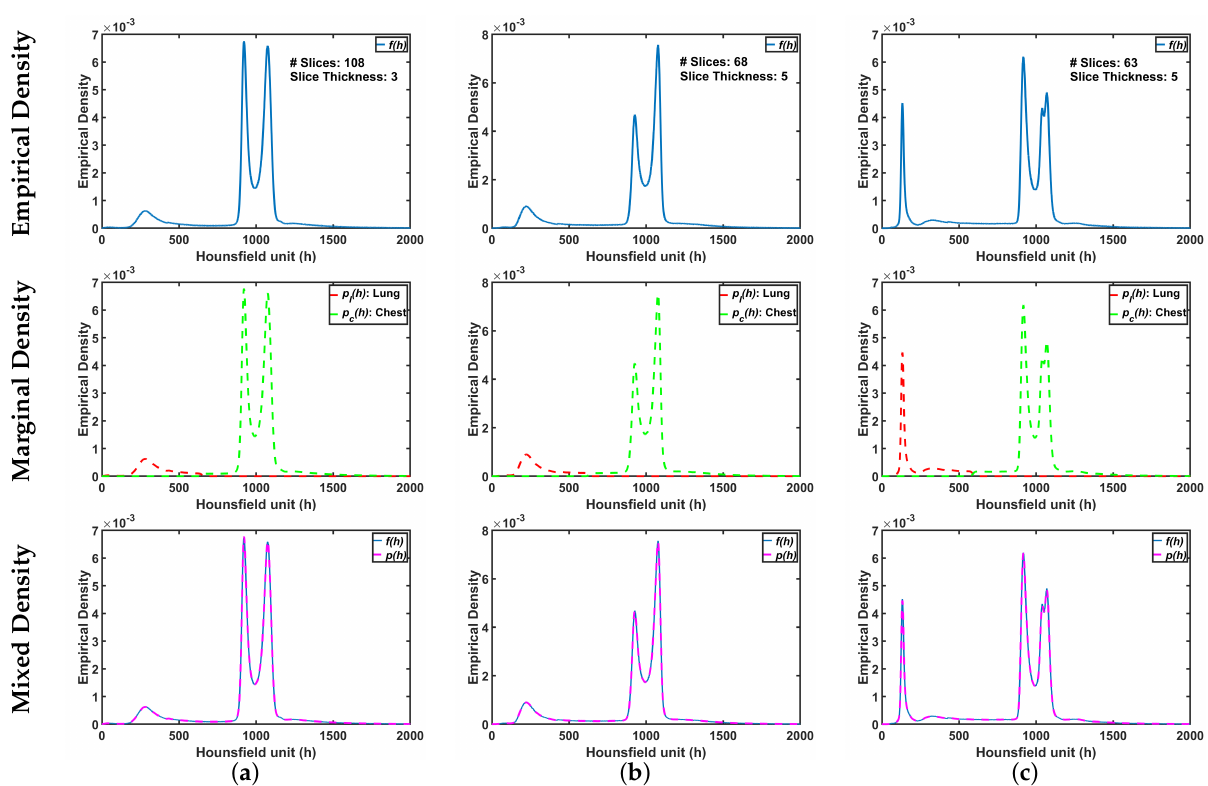
Figure 6. An illustrative example of the proposed appearance model estimated from Thick-Section CT appearance model for ( a ) healthy/mild, ( b ) moderate, and ( c ) severe COVID-19 infected lung. Note that first, second, and third rows represent empirical, marginal, and mixed densities,